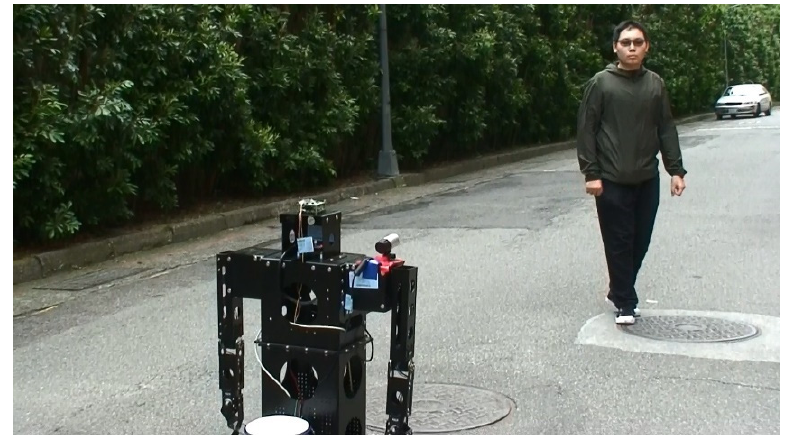
Figure 27. Someone appeared on the pathway.